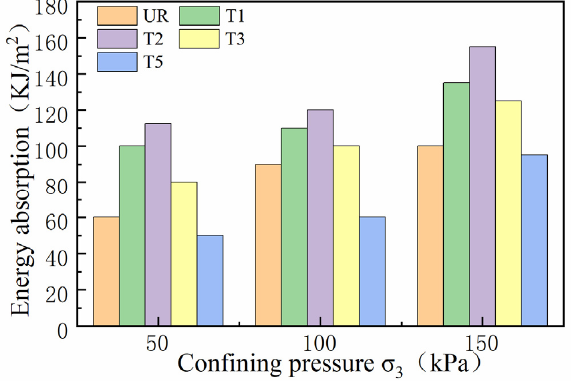
Figure 13. Energy absorption of waste tire reinforced track bed.